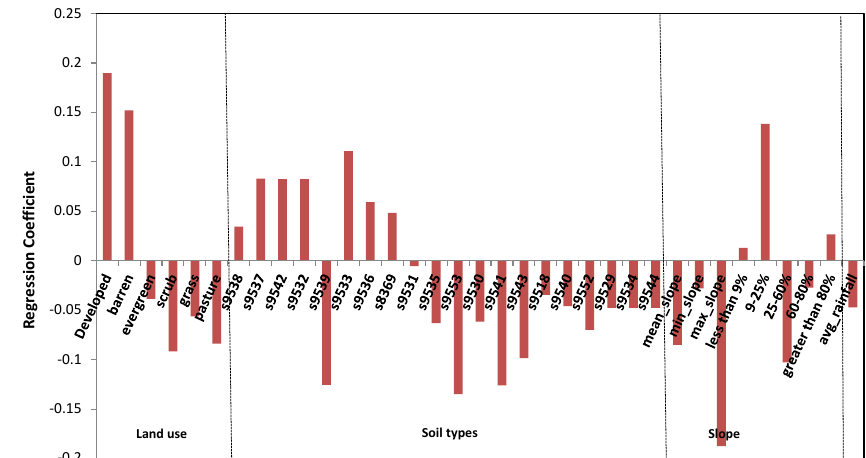
Figure 4. PLS regression coefficients of each predictor on SS load. Fig. 4: PLS regression coefficients of each predictor on SS load